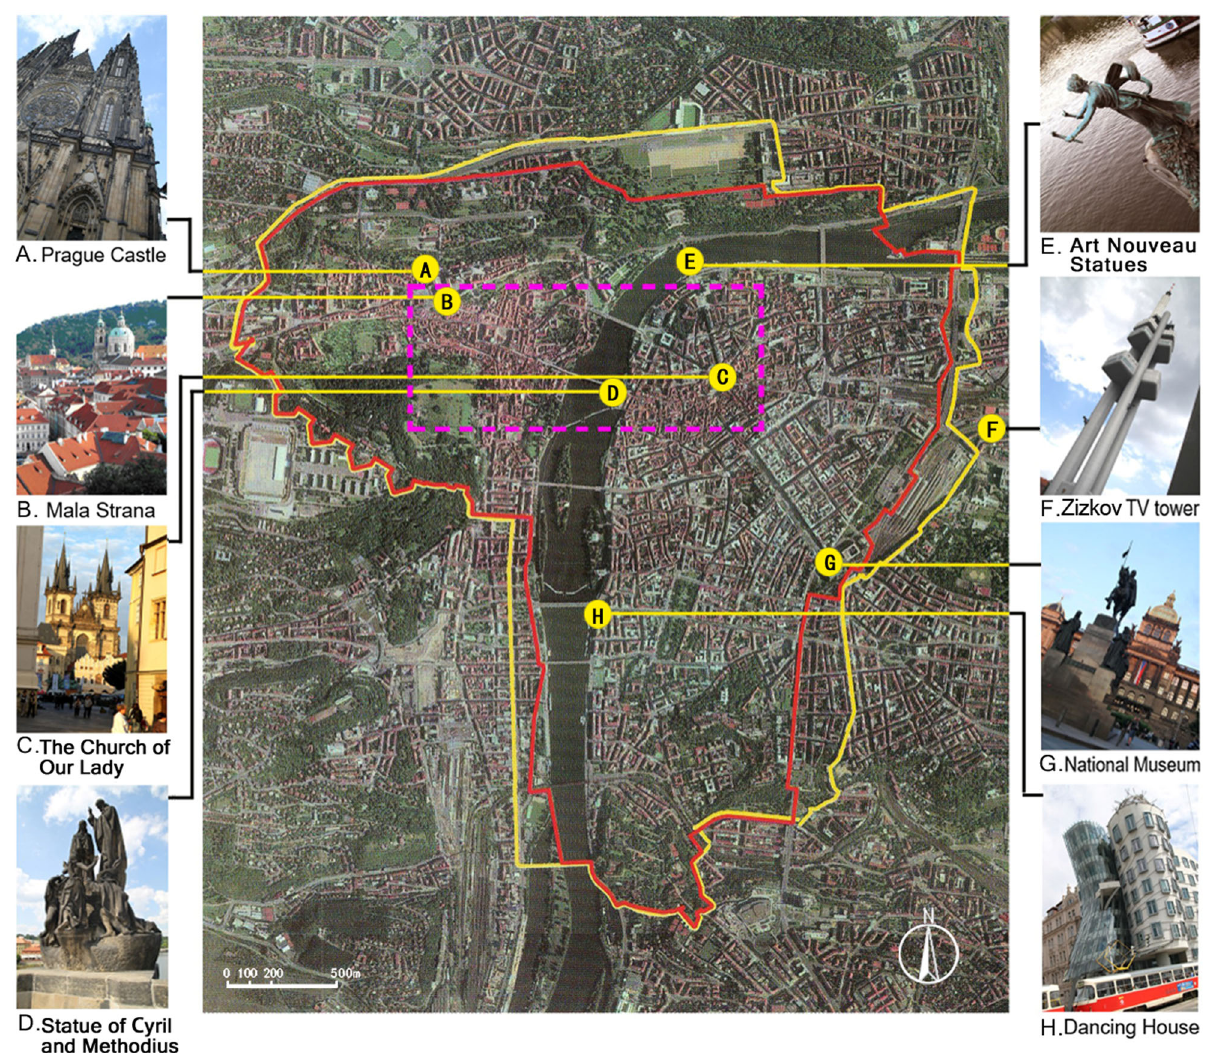
Fig. 1 Main attractions in Prague Historical Reserve. Old Town and Malá Strana (Lesser Town) are highlighted with a purple